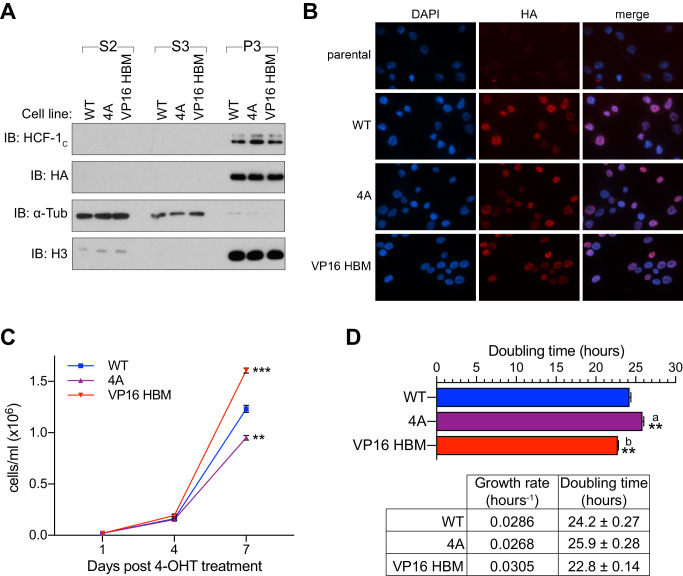
Localization of MYC mutants and their impact on cell doubling time.(A) Chromatin fractionation of switchable Ramos cells was performed after a 24 hr treatment with 20 nM 4-OHT. S2 reflects the cytosolic, S3 the non-chromatin nuclear, and P3 the chromatin-bound fraction. Each fraction was probed using antibodies against host cell factor (HCF)–1C, HA, α-Tubulin, and H3. (B) Immunofluorescence of cells that had been switched for 24 hr as in (A), using a DAPI DNA stain and an antibody against the HA tag on switched MYC proteins. (C) Switchable Ramos cell lines were treated with 20 nM 4-OHT for 16 hr, then re-plated 24 hr later at a density of 2 × 104 cells/ml. The number of cells, including both green fluorescent protein (GFP)– and GFP+, was counted at 3 and 6 days following re-plating. Shown are the mean and standard error for three biological replicates. Student’s t-test between wild-type (WT) and mutant cells was used to calculate p-values; **=0.0023, ***=0.00087. (D) Using the difference in cell number between day 1 and day 7 from (C), we calculated growth rate and subsequently the approximate doubling time for each cell line following switching. Bar graph shows the mean and standard error for the three biological replicates. Student’s t-test between WT and mutant cells was used to calculate p-values; a = 0.002, b = 0.0012. Table below shows the mean growth rates and doubling time ± standard deviation.